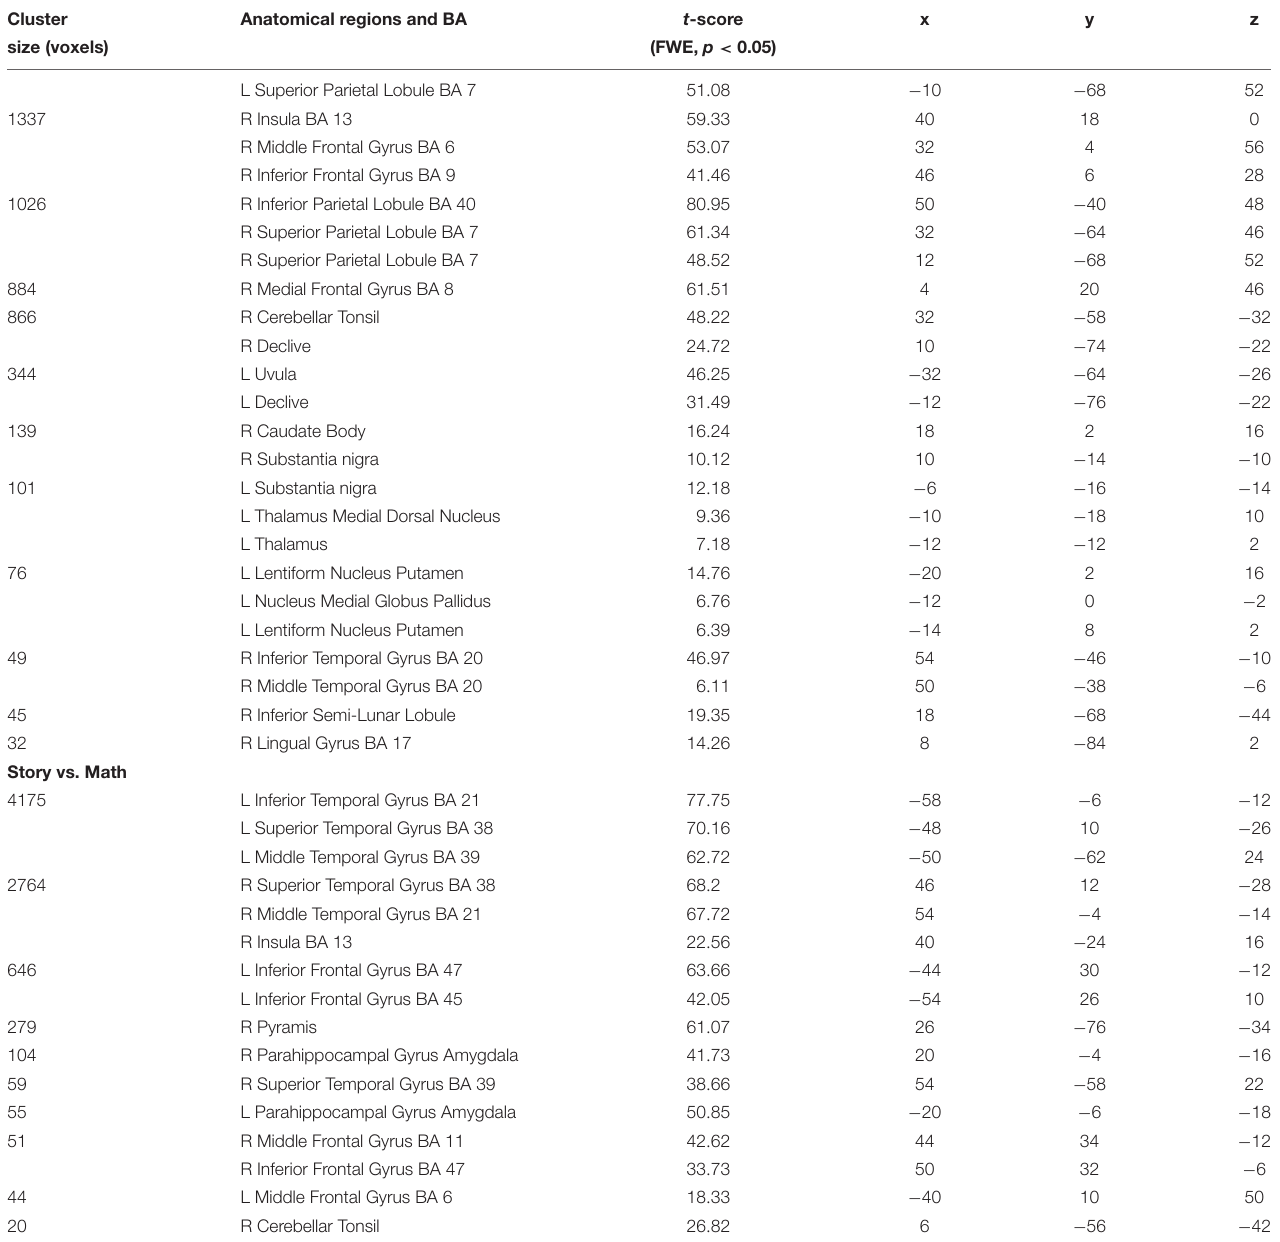
Table 2 , it was found that 13 of the 25 characteristic brain regions overlapped with the group analysis activated brain regions. Among the 13 brain regions, there were 11 brain regions that overlapped with a different activation map between the math task and the story task. The 11 brain regions were: the left and right Inferior Parietal Lobe (not include supramarginal and angular gyri), left and right Middle Frontal Gyrus, left Supramarginal Gyrus, right Superior Parietal Gyrus, right Superior Frontal Gyrus, dorsolateral, right Inferior Frontal Gyrus, opercular part, right Angular Gyrus, left Amygdala, left Heschl Gyrus.